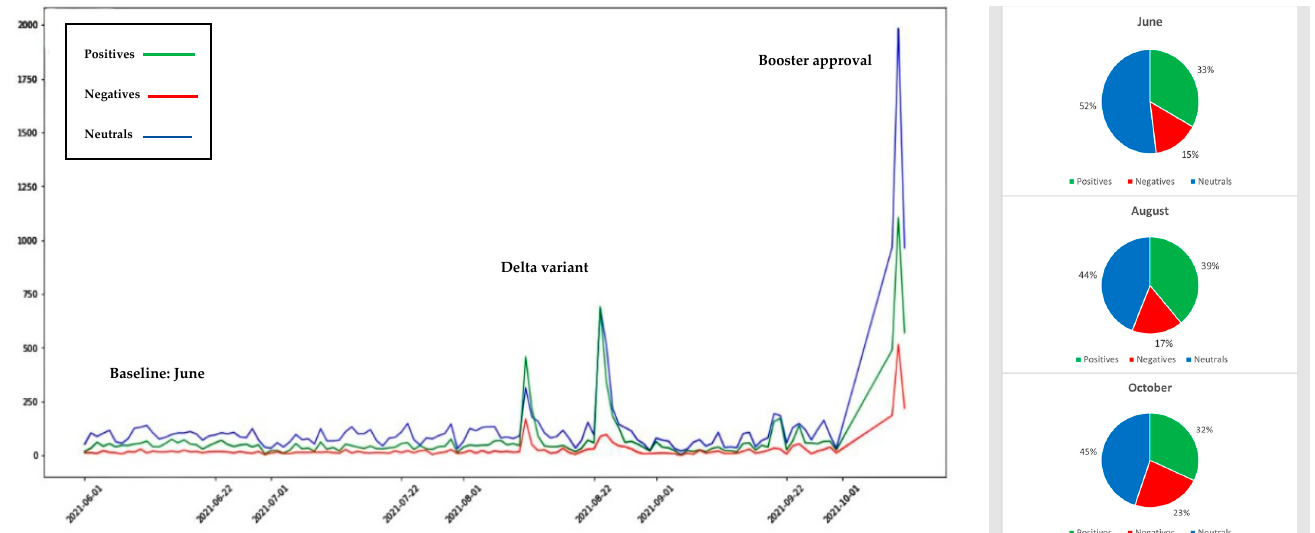
Figure 4. Sentiment analysis results of tweets related to Pfizer vaccine.